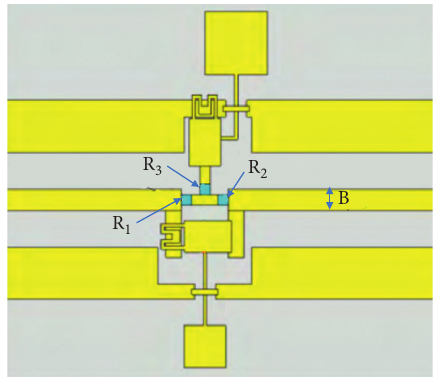
Figure 9: Attenuation circuit diagram.